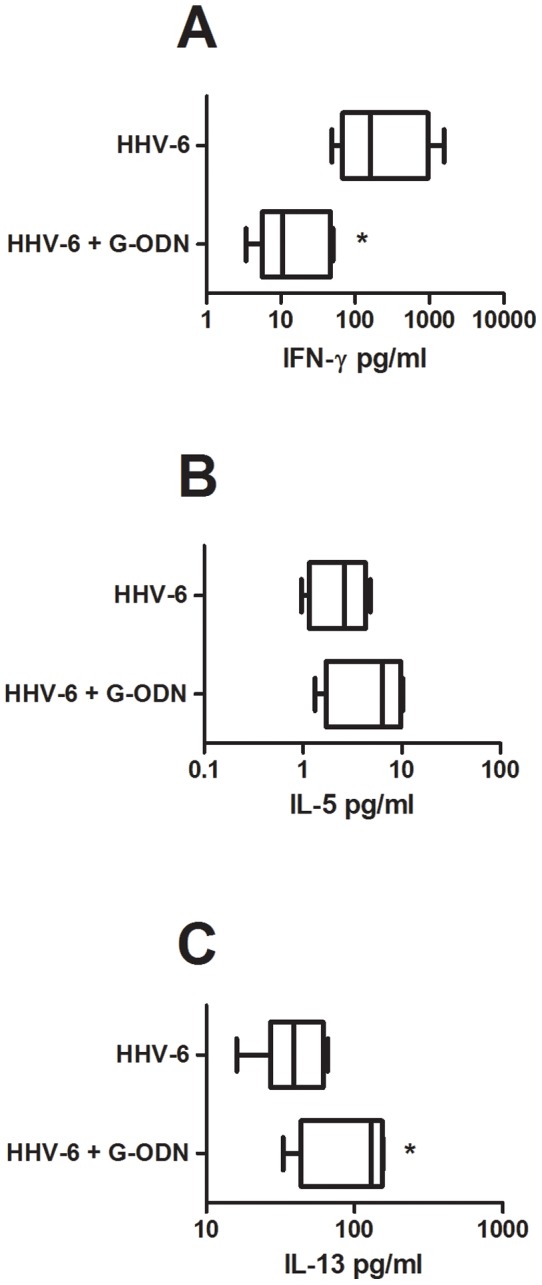
HHV-6B affects the IFN-gamma and IL-13 responses in cord mixed lymphocyte reactions via TLR9 signaling.Cord blood pDC were incubated with allogeneic cord-blood CD4+ T-cells and inactivated HHV-6B in the presence or absence of G-ODN. Supernatants were collected after 48 h and analyzed for IFN-gamma (A), IL-5 (B) and IL-13 (C) content. Data are expressed as medians and the 25% and 75% percentile (the boxes) with the minimum and maximum responses for n = 5. *  =  p<0.05 using student's t-test.